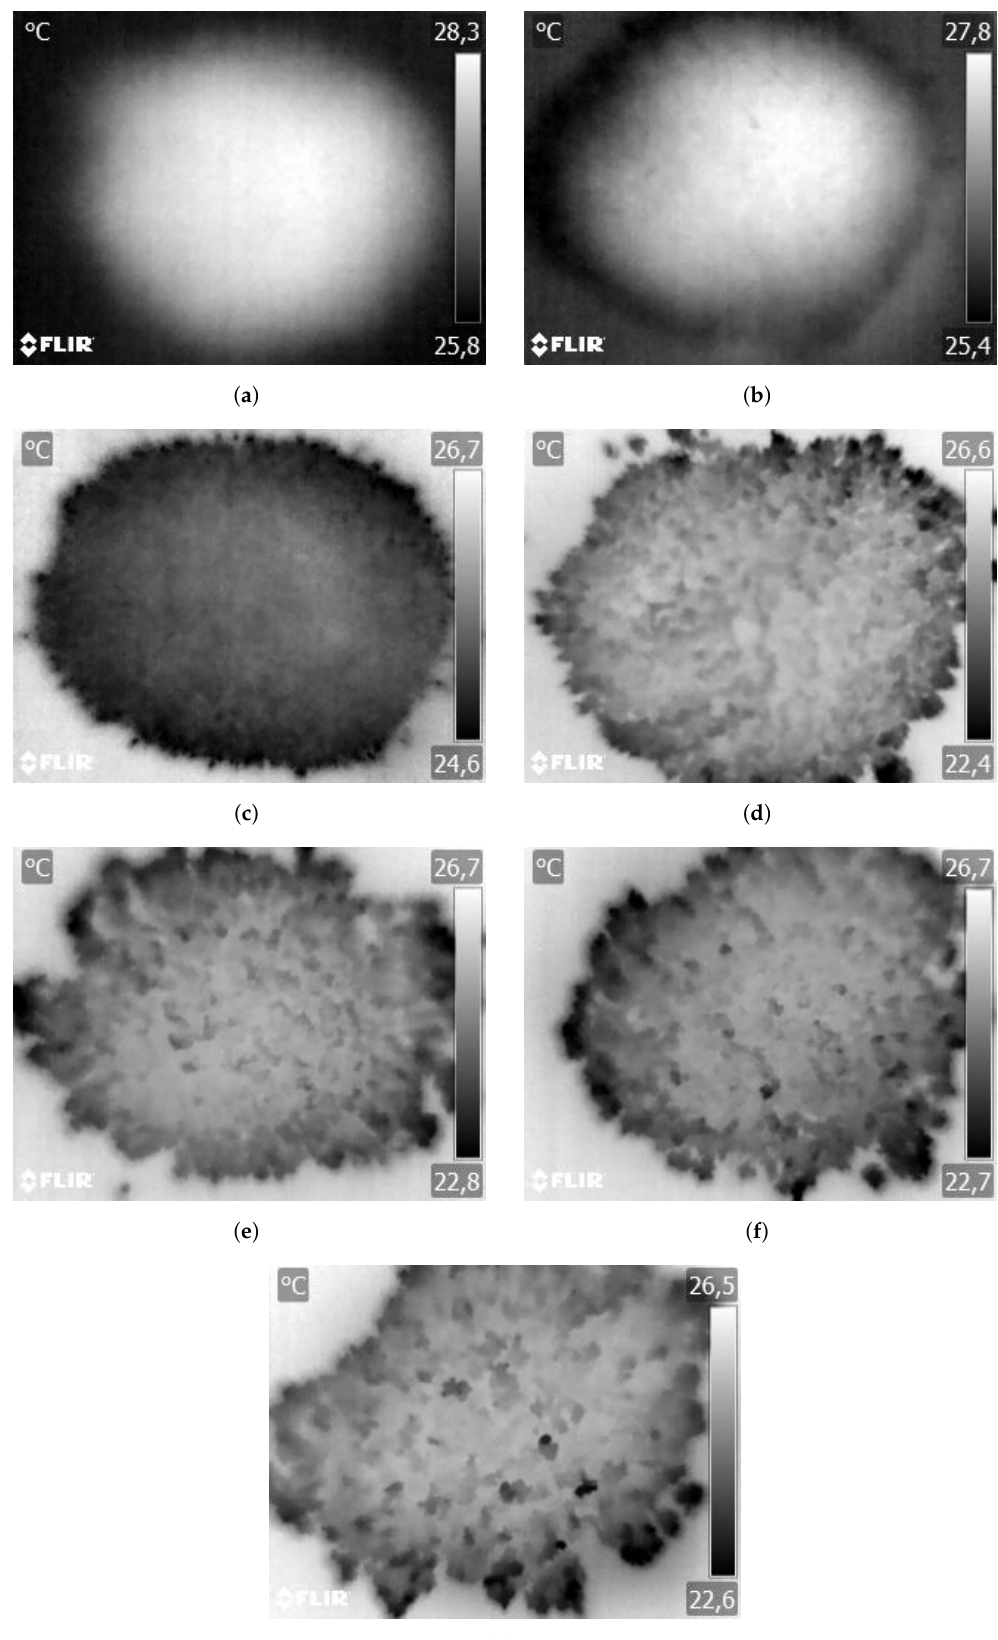
Figure 12. Sequence of IR images for 0.5–1 mm material with moisture contents of: ( a ) 0.5%, ( b )